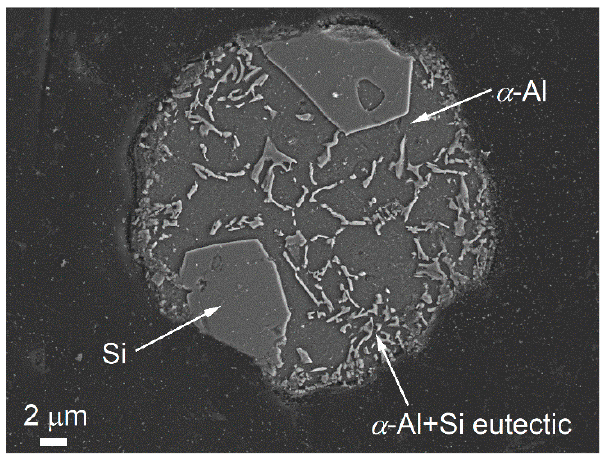
Figure 2. SEM images (secondary electron images) of the cross-section of an Al-20Si particle (Particle I) solidified at 5000 K/s, etched with Weck’s reagent.